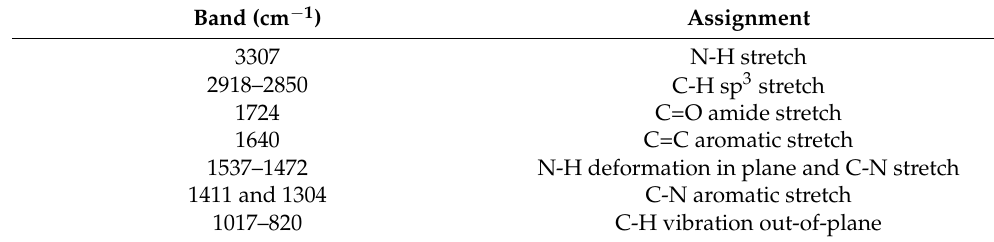
Table 2. Assignment of FTIR/ATR bands.